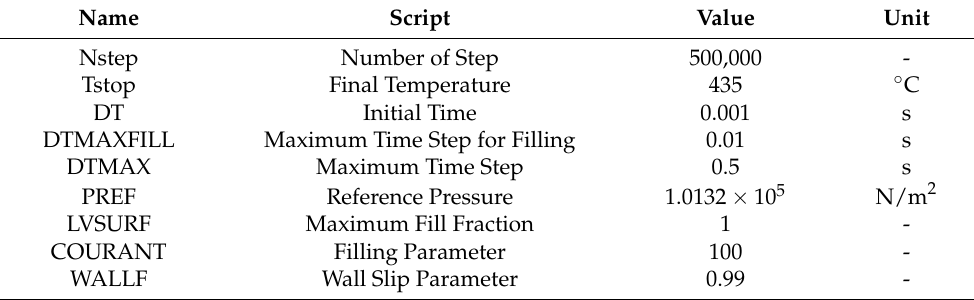
Table 1. Simulation parameter